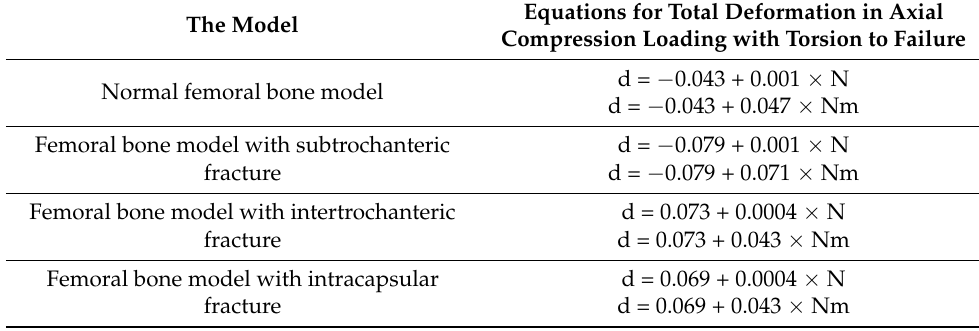
Table 7. Equations for total deformation in axial compression loading with torsion to